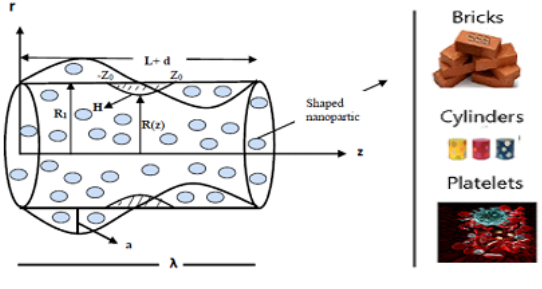
Fig. 1: Physical model of the